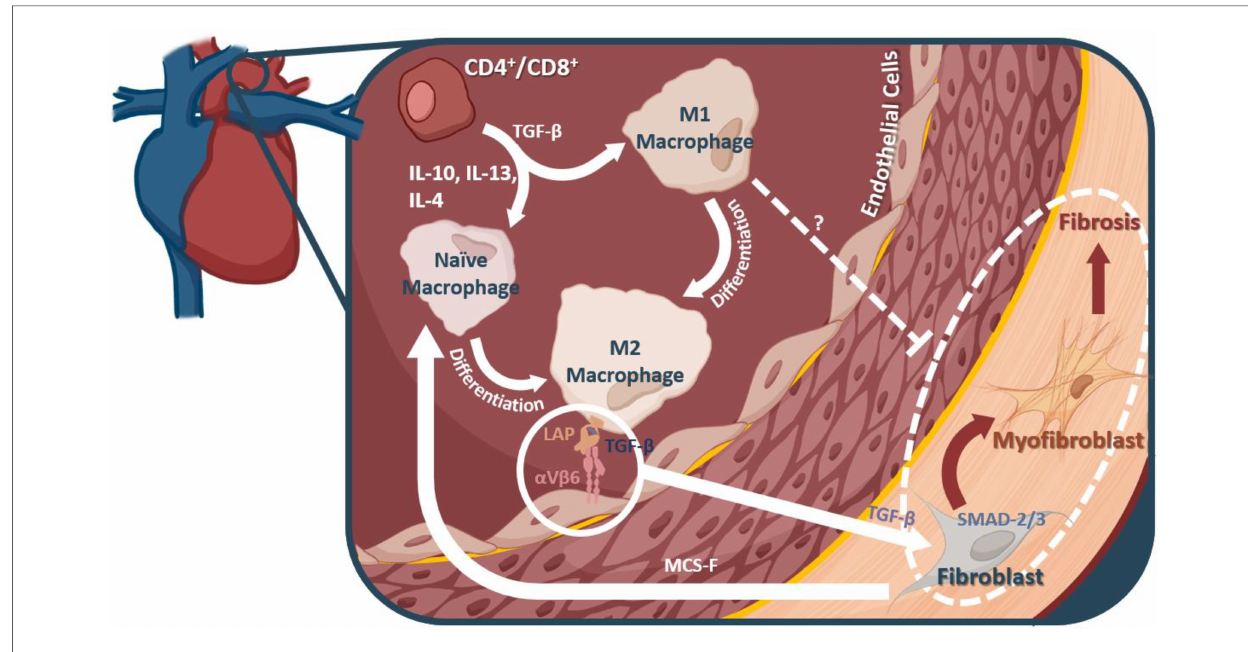
FIGURE 2 Macrophages and their mechanistic role in fi brosis. M2 macrophages can interact with α V β 6, thereby releasing a TGF- β inhibitor protein, and allowing them to interact with fi broblasts in the heart. TGF- β leads to myo fi broblast differentiation from fi broblasts via the SMAD2/3 pathway. It is these myo fi broblasts that are thought to account for much of the fi brotic remodeling in many diseases, including diastolic dysfunction and heart